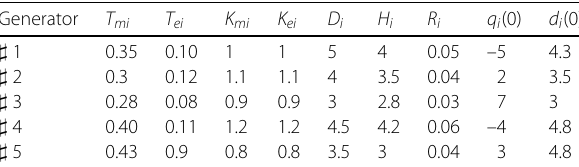
Table 1 System and controller parameters